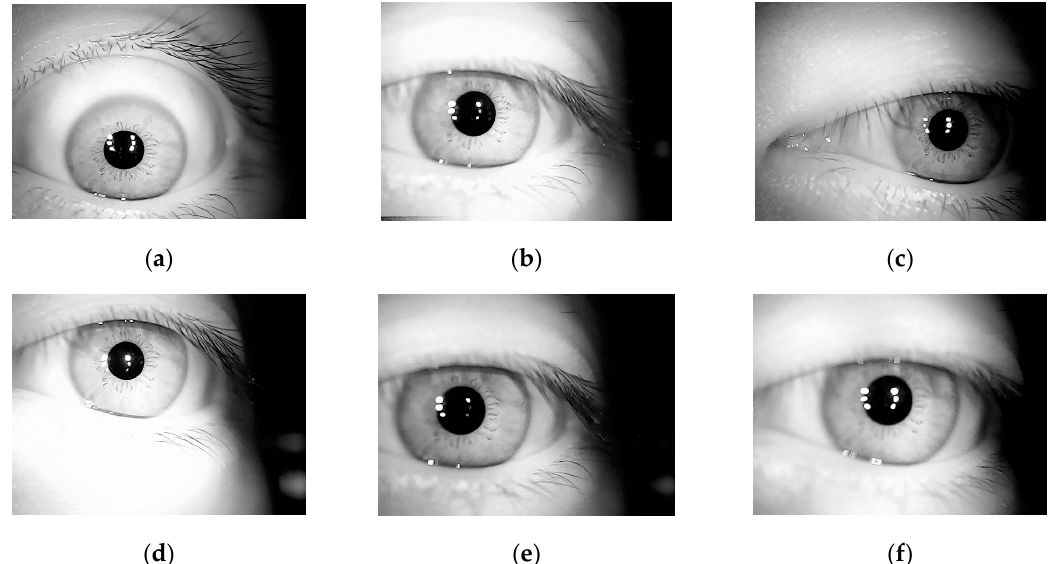
Figure 3. Examples of eye images of the same person at different shooting times: ( a , b ) clear grayscale image with normal light conditions; ( c , d ) clear grayscale image with darker and brighter light conditions, respectively; ( e , f ) blurred grayscale images.